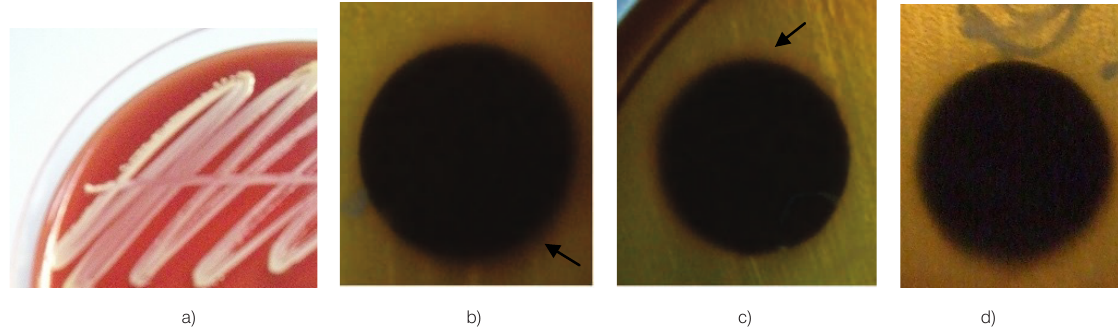
Figure 4. The disc alloys in contact with S.aureus : a) Pure culture b) Zr2,5Nb c) Zr10Nb d) Zr10Ta.